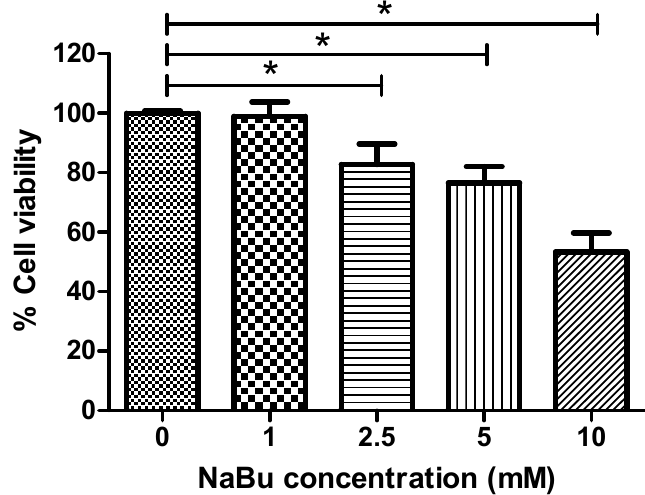
Figure 2. The effect of sodium butyrate (NaBu) on human Wharton’s jelly–derived mesenchymal stem cells (hWJ–MSCs) cytotoxicity. hWJ–MSCs were cultured with 0–10 mM NaBu for 3 days in 96–well plates. The cell viability was assessed via MTT assays. The data are shown as means ± SD. * p < 0.05.